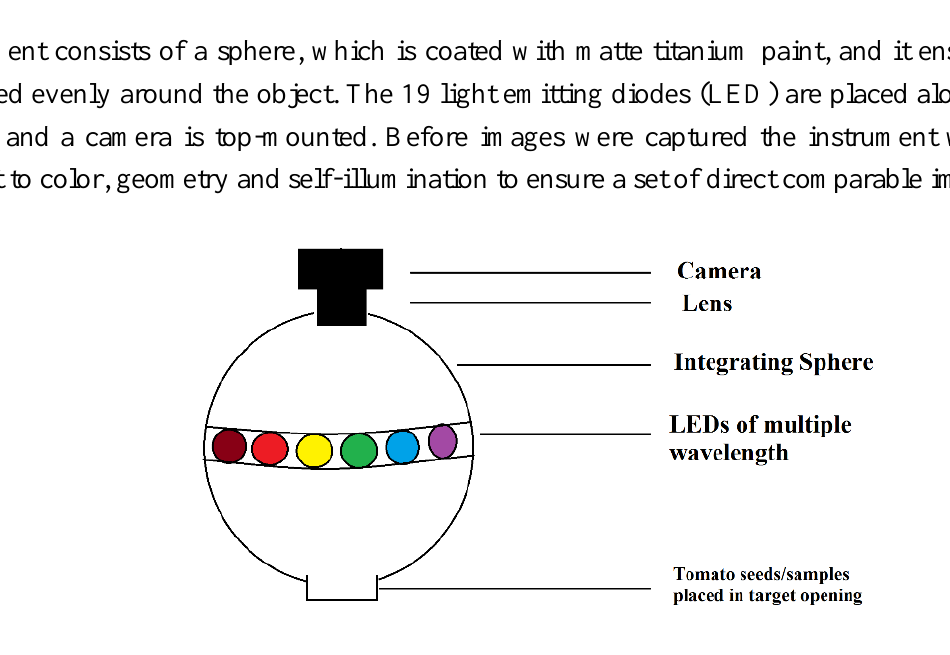
Figure 1. VideometerLab instrument structural set up for capturing multispectral